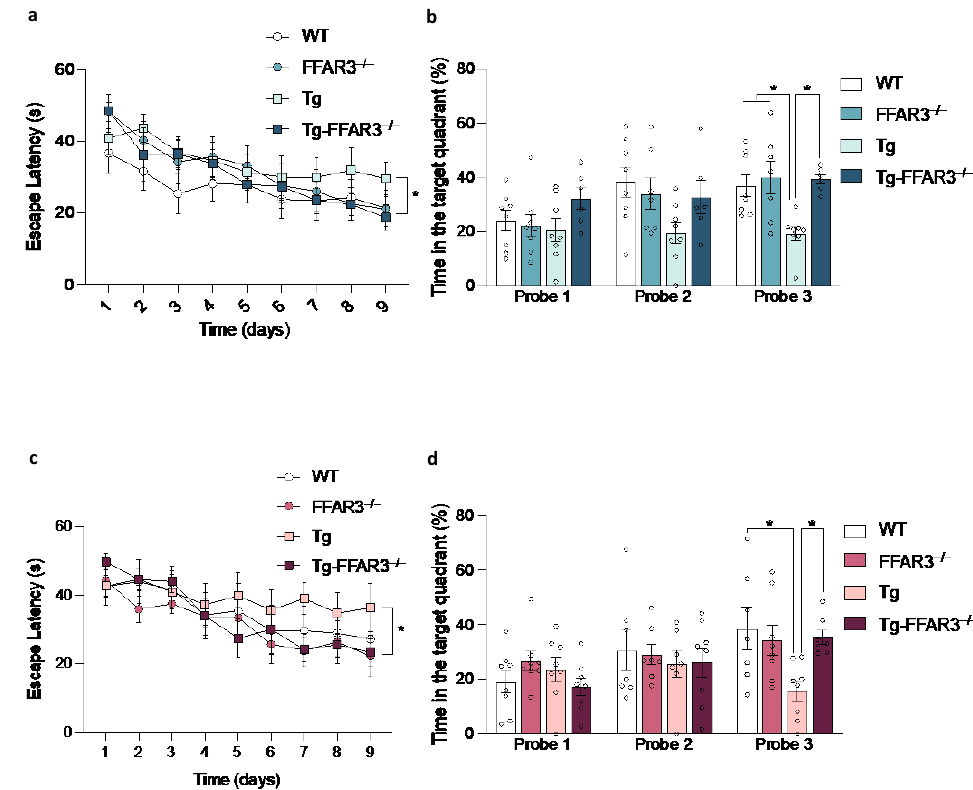
Figure 4. FFAR3 ablation prevents the cognitive deficiency observed in 15-month-old Tg2576 mice. Spatial memory evaluation by Morris water maze (MWM) ( a ) memory acquisition and ( b ) memory retention phase of wild type (WT), FFAR3 knockout (FFAR3 −/− ), Tg2576 (Tg) and Tg2576 FFAR3 knockout mice (Tg-FFAR3 −/− ) fed with NCD. MWM ( c ) memory acquisition and ( d ) memory retention phase of mice subjected to HFD. Results are expressed as mean ± SEM and circles in the subfigures represent each individual value ( n = 6–9 in each group). * p < 0.05 two-way ANOVA followed by Tukey.